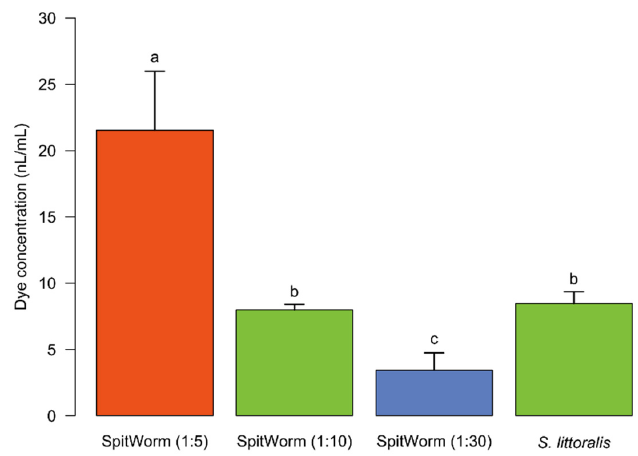
Figure 6. Fluorescent dye concentrations extracted from wounding edge tissues after different treatments. Treatments: S. littoralis injected with fluorescent solution; SpitWorm delivering different dilutions of labeled larval OS (1:5, 1:10, 1:30); n = 3 for each treatment; mean ± SD; one-way ANOVA; post hoc test: Fisher’s LSD; treatments with identical letters are not significantly different.